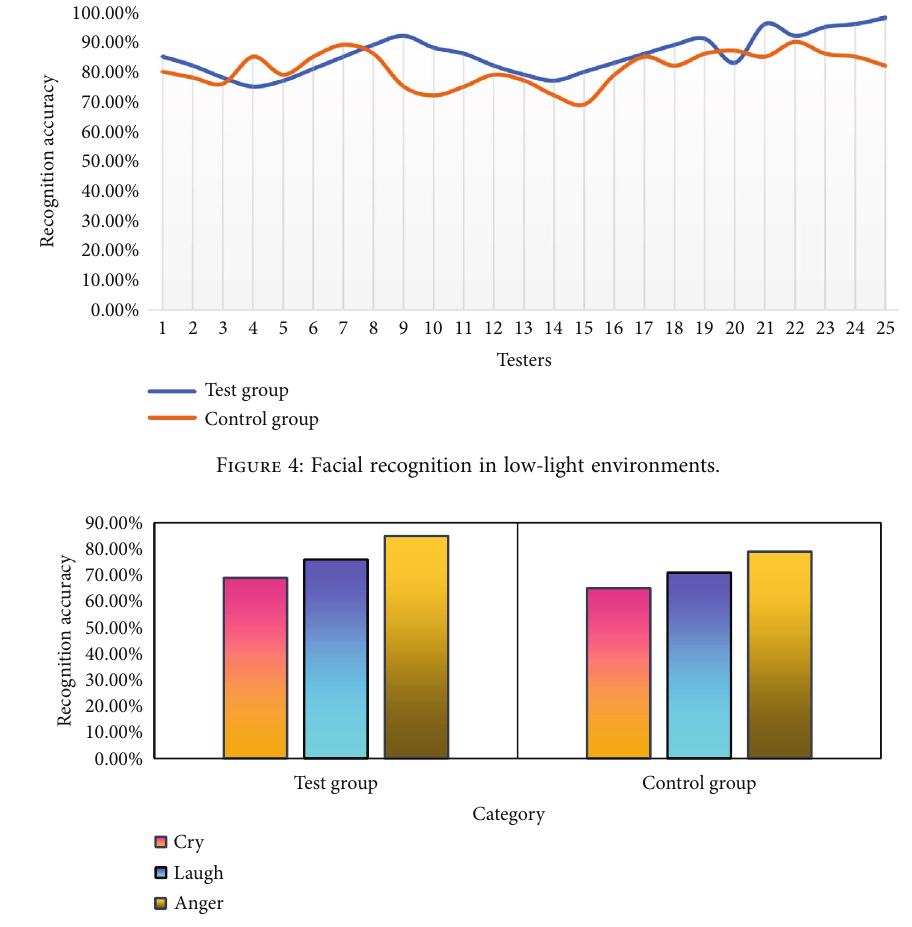
Figure 5: Facial recognition under di ff erent expression